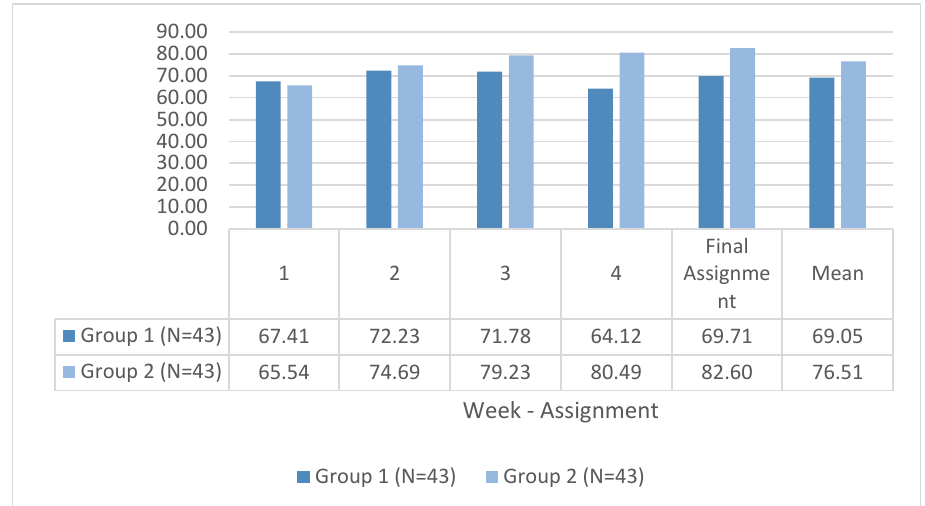
Figure 5. Week-assignment group note distribution.